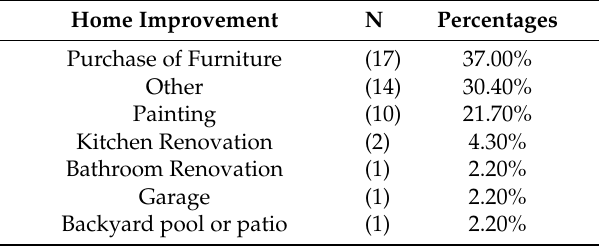
Table 13. Home Improvements by Houston Habitat Homeowners Respondents.